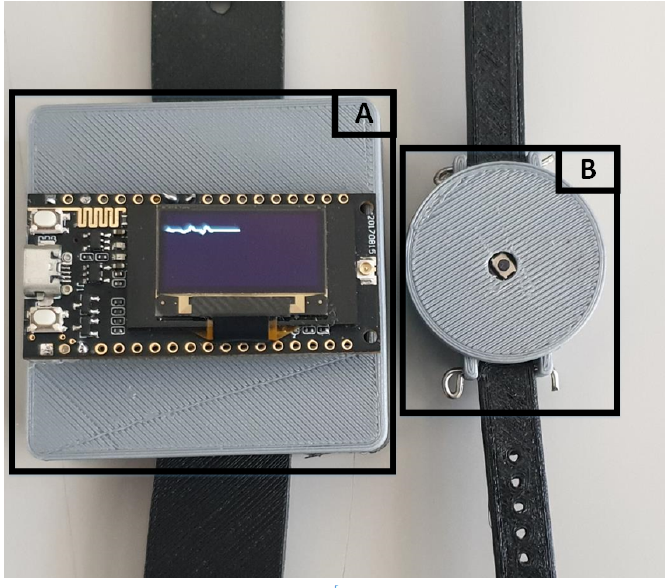
Figure 1. Wristband A and Wristband B (motion detector)